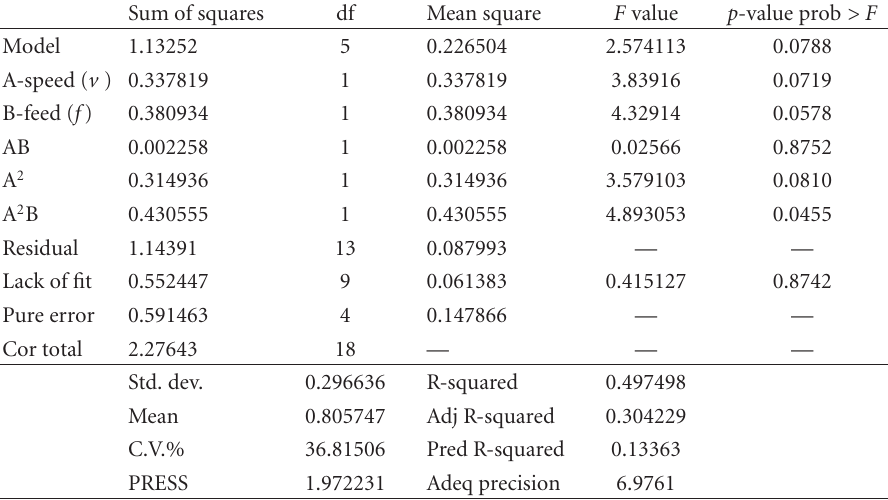
Table 6 . 1 . ANOVA for response surface reduced cubic chip thickness model.